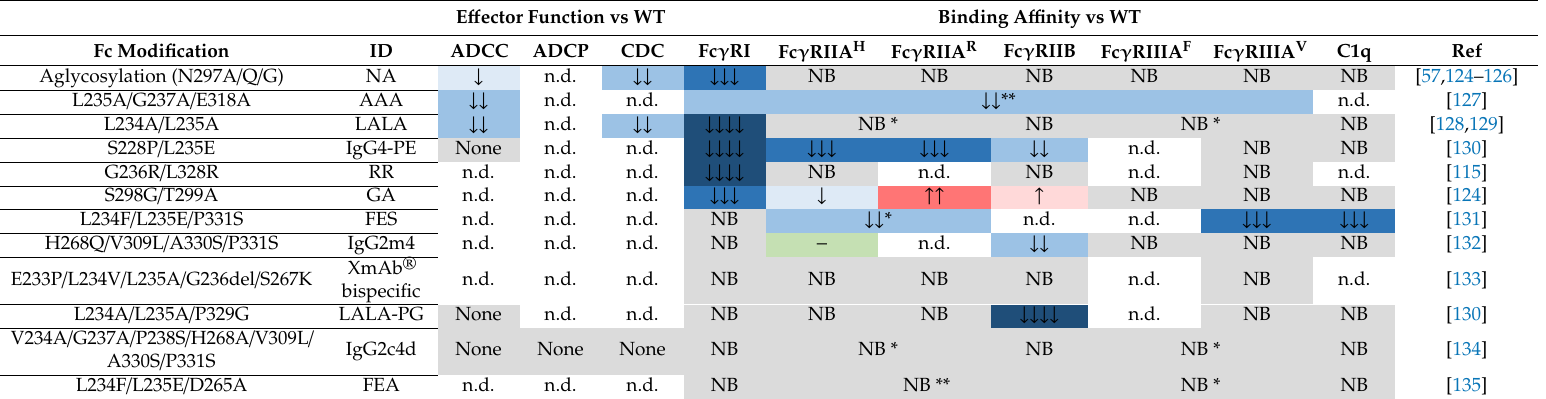
Table 3. Reduction in e ff ector function or binding a ffi nity to Fc γ Rs in Fc-silenced variants compared to WT